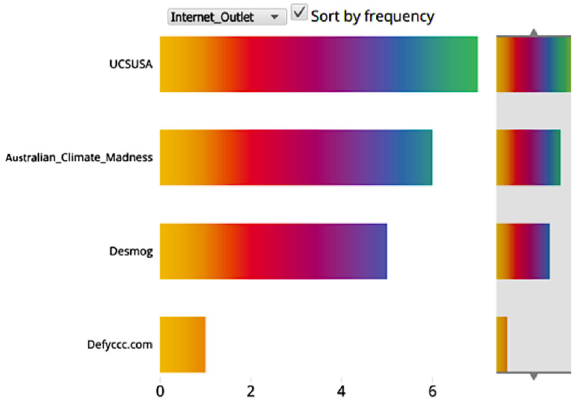
Fig. 6 Metafacet visualization for a concordance featuring peer review in CSBC (19 lines), fi ltered by Internet outlet and sorted